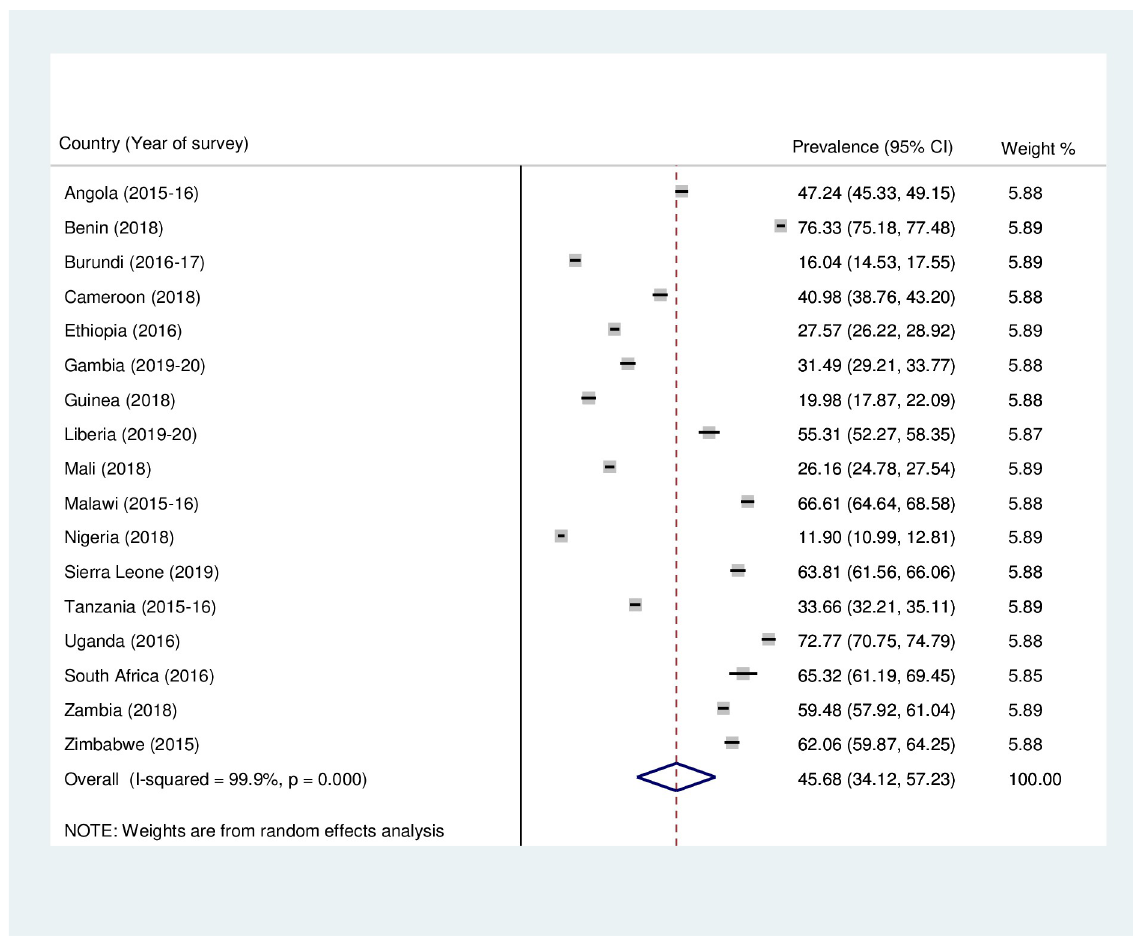
Fig 1. Forest plot showing the prevalence of mother and newborn skin-to-skin contact in sub-Saharan Africa.